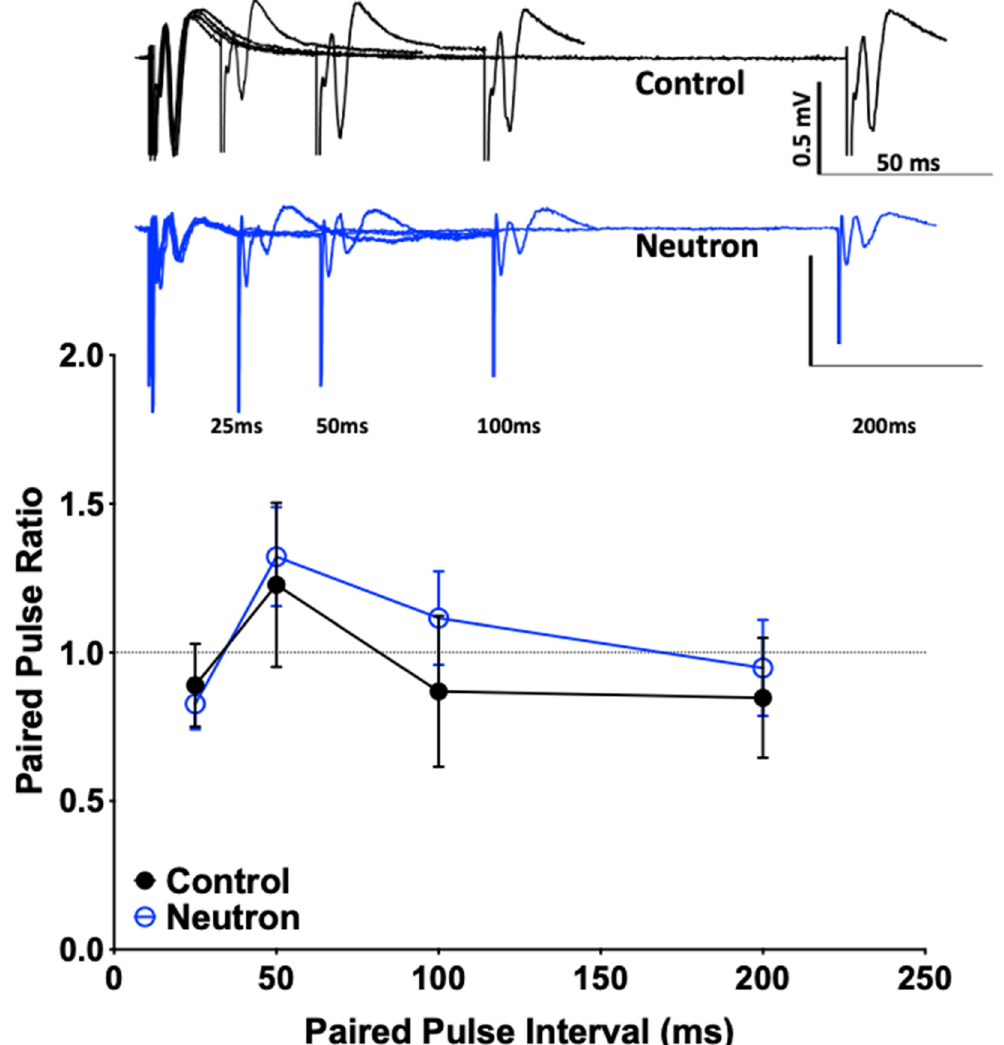
Figure 10. Paired pulse ratio is not significantly different between the control and the chronic low dose neutron-irradiated group. Representative traces for the control (black) and the neutron irradiated group (blue) are provided. There is no significant difference in the paired pulse ratio (calculated as the fEPSP slope of second pulse over the first) at four different intervals tested (25, 50, 100 and 200 ms), suggesting that there is no presynaptic deficit that accounts for the effects of the irradiation associates synaptic or behavioral changes.